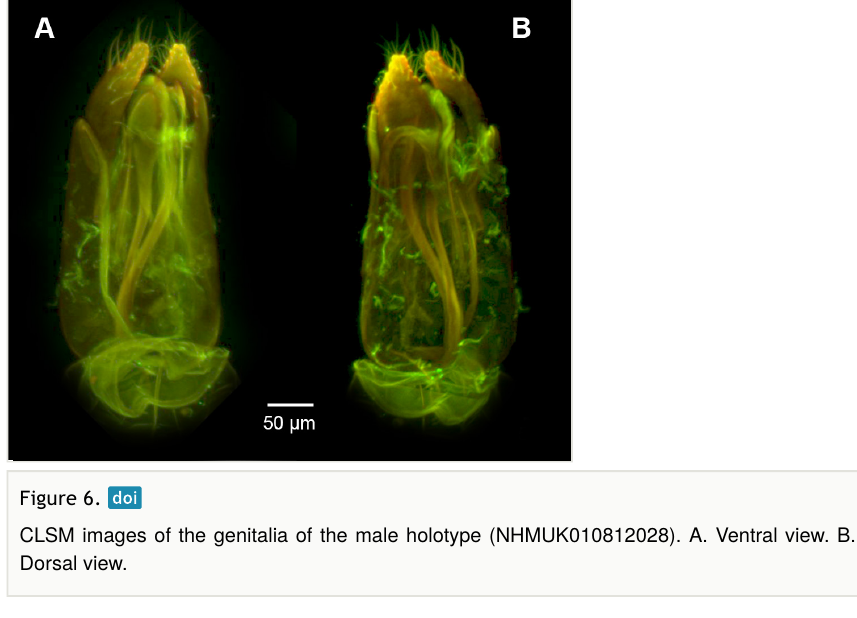
Figure 6. CLSM images of the genitalia of the male holotype (NHMUK010812028). A. Ventral view. B. Dorsal